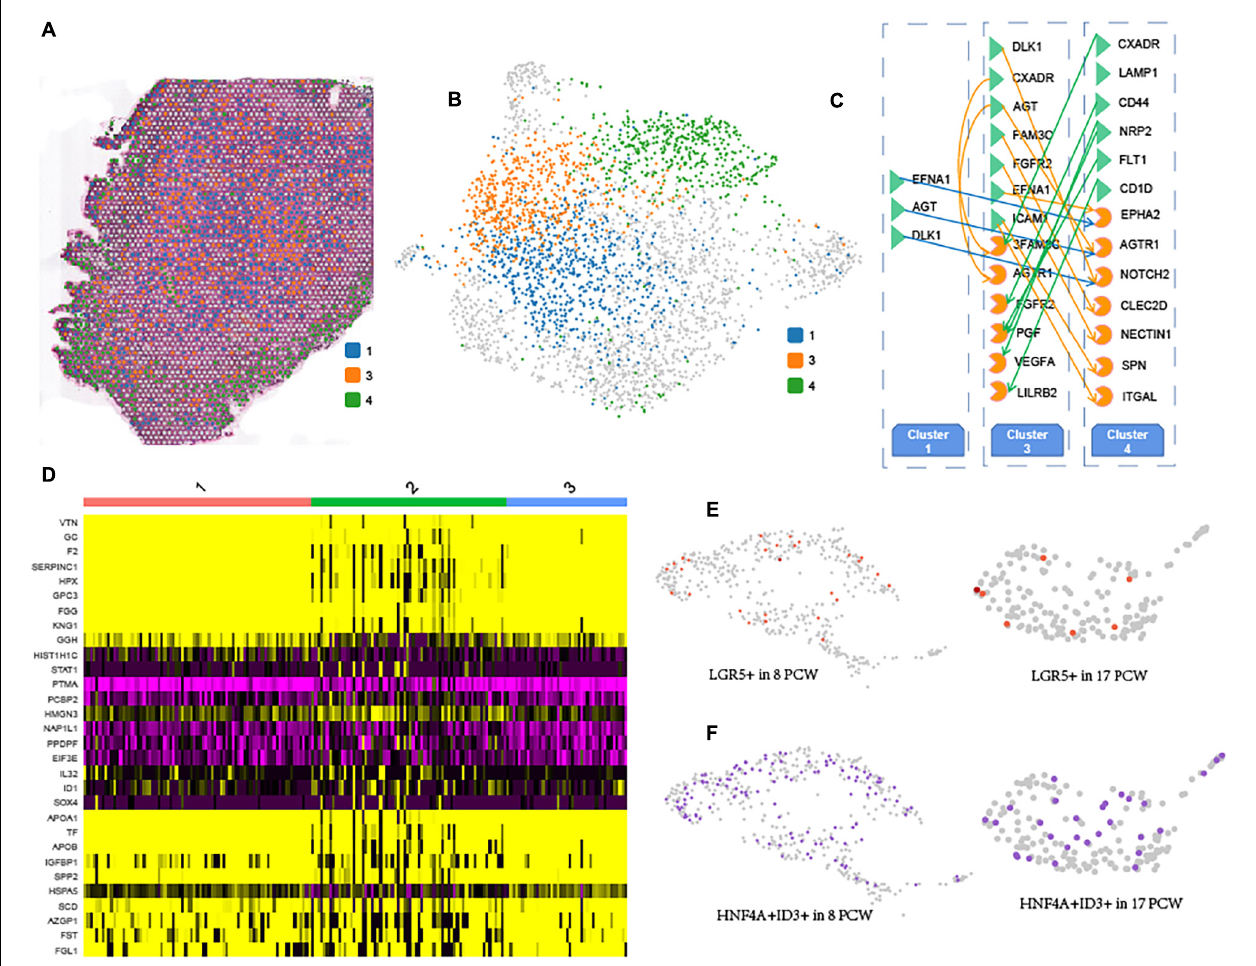
FIGURE 4 | Spatially Resolved Heterogeneity of Human Fetal Hepatocytes. Three main subpopulations of hepatocyte were showed in tissue sections (A) and UMAP plot (B) . Matching plots showing the significant signaling transduction regulation between the Cluster 1-3-4 cells (C) . “Green triangle” represents the ligand, and “Orange irregular shape” represents receptor in the ligand-receptor pairs. Heat map of the top 10 abundant genes in each cluster (D) . Plots showing the expression of LGR5 in the hepatocyte of 8 PCW and 17 PCW liver (E) , and Plots showing the expression of HNF4A and ID3 gene in the hepatocyte of 8 PCW and 17 PCW liver (F) , and the gradient of red (purple) reflects expression